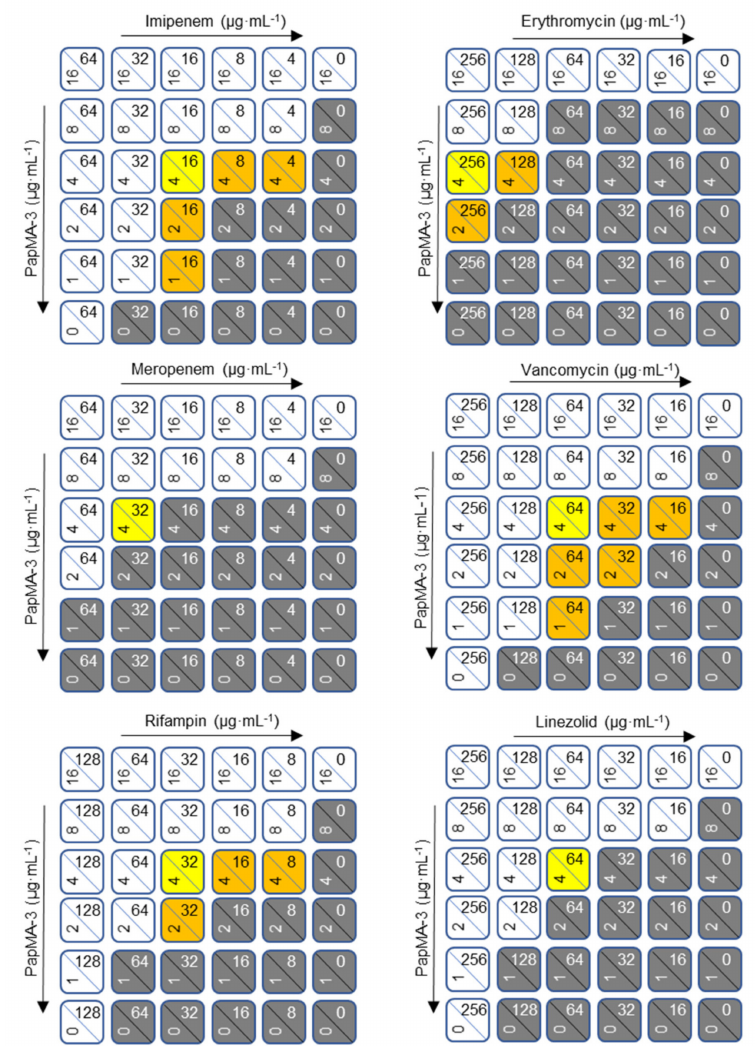
Figure 5. Checkerboard assays of PapMA-3 in combination with six conventional antibiotics against CRAB C1. PapMA-3 and antibiotics were subjected to 1/2 dilution vertically and horizontally from the MIC concentration at the upper left corner. White (0.5 < FICI < 2) indicates a partial synergistic effect, yellow (FICI = 0.5) and orange (FICI < 0.5) indicate a synergistic effect, and gray indicates growth of bacteria. We defined MIC that inhibits completely over 99% of CRAB C1 bacterial